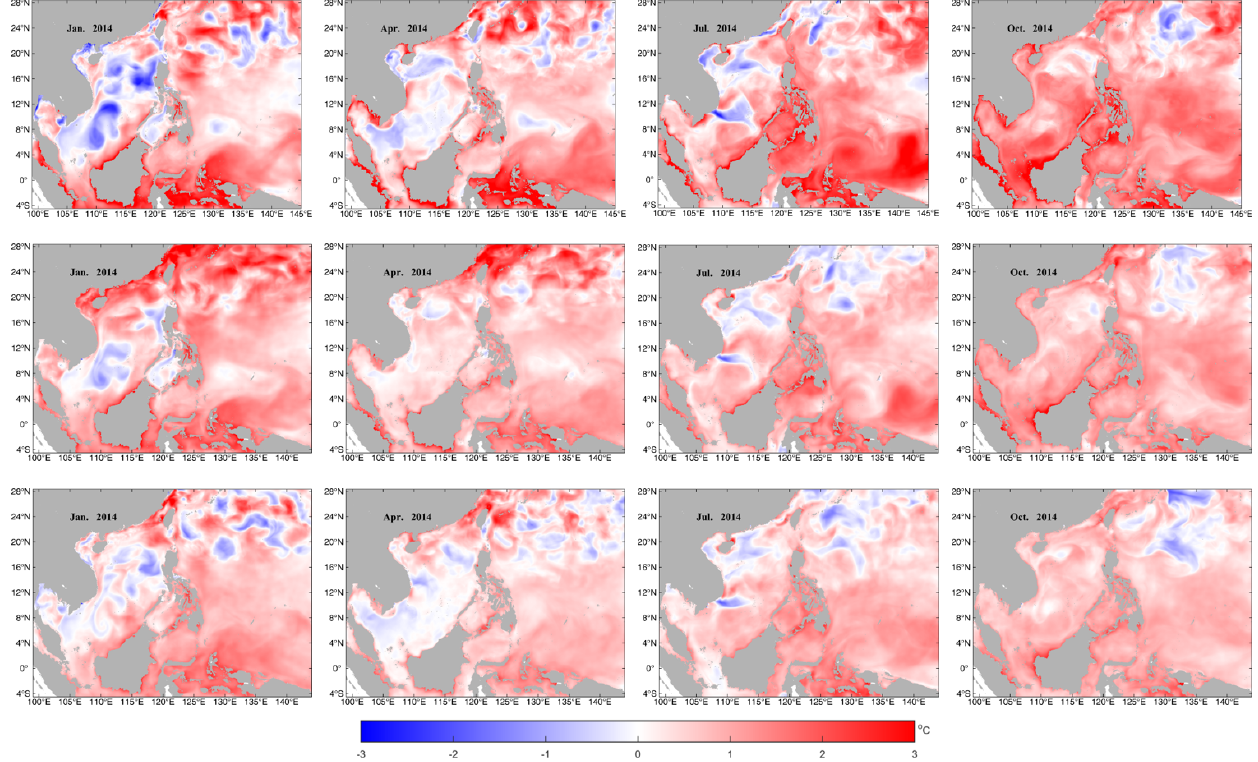
Figure 3. The monthly mean SST differences in January, April, July, and October of 2014: SCSOFSv1 minus OSTIA (upper row), BulkFor- mula minus OSTIA (middle row), and SCSOFSv2 minus OSTIA (lower row).